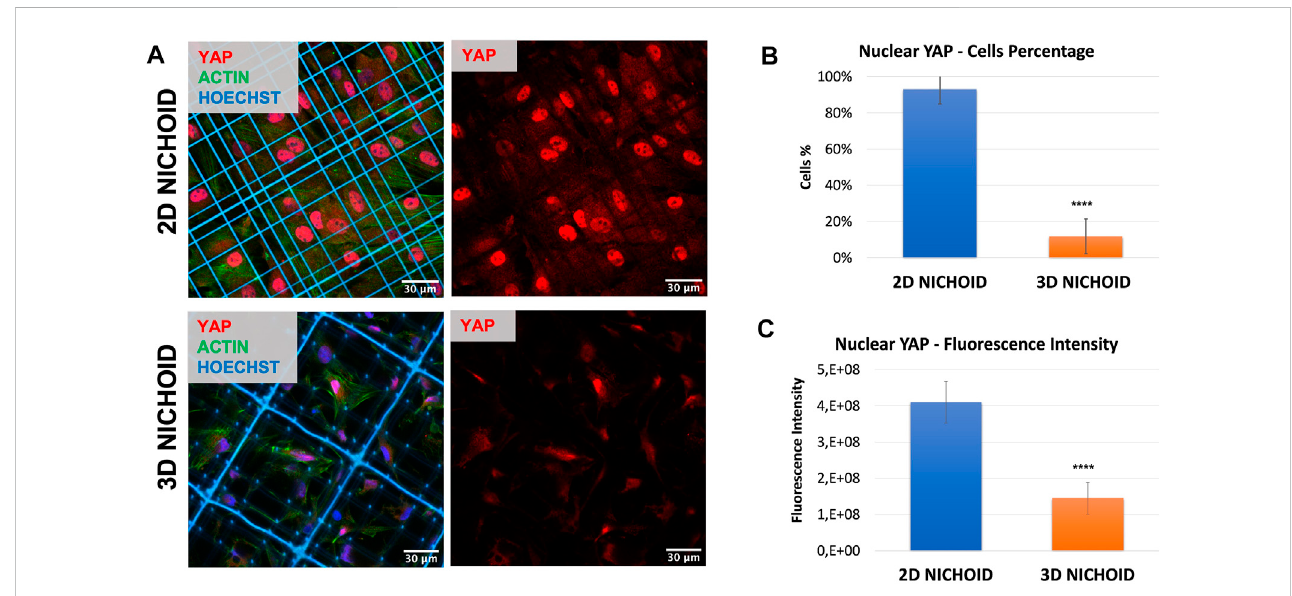
FIGURE 2 (A) Immuno fl uorescence images of rBMSCs with stained nuclei (blue), actin (green), and YAP (red) in 3D and 2D Nichoids. Scale bar = 30 µm. (B) Quanti fi cationoftherBMSCpercentageofcellswithYAPmainlylocalizedinthenucleus;****indicates p value ≤ .0001forthe3Dvs.2DNichoidcomparison ( n = 4). (C) Quanti fi cation of rBMSCs ’ fl uorescence intensity of nuclear YAP; **** indicates p value ≤ .0001 for the 3D vs. 2D Nichoid comparison ( n =